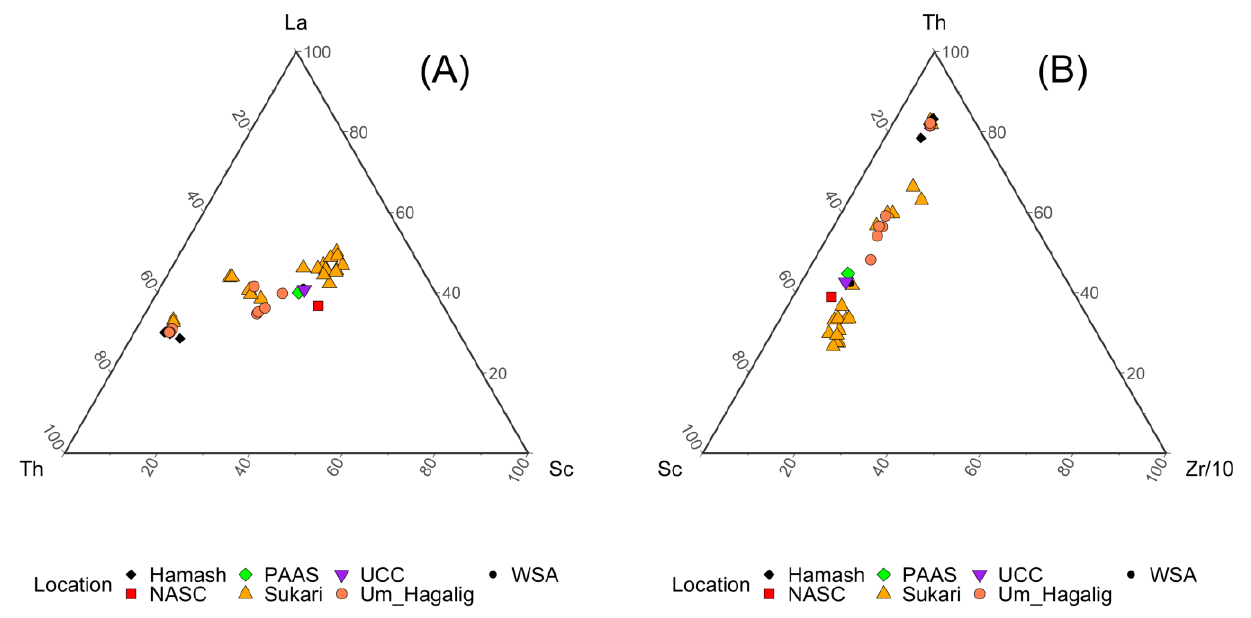
Figure 9. ( A ) a ternary diagram shows the distribution of La-Th-Sc and ( B ) the distribution of Th- Zr/10-Sc. For comparison purposes, the corresponding values of the elements were considered for UCC by Rudnick and Gao [41], NASC by Gromet, Haskin, Korotev and Dymek [38], Taylor and McLennan [40] for Post Archean Australia Shale PAAS, and Kabata-Pendias [39] for world soil av- erage WSA. Background after Bhatia and Crook